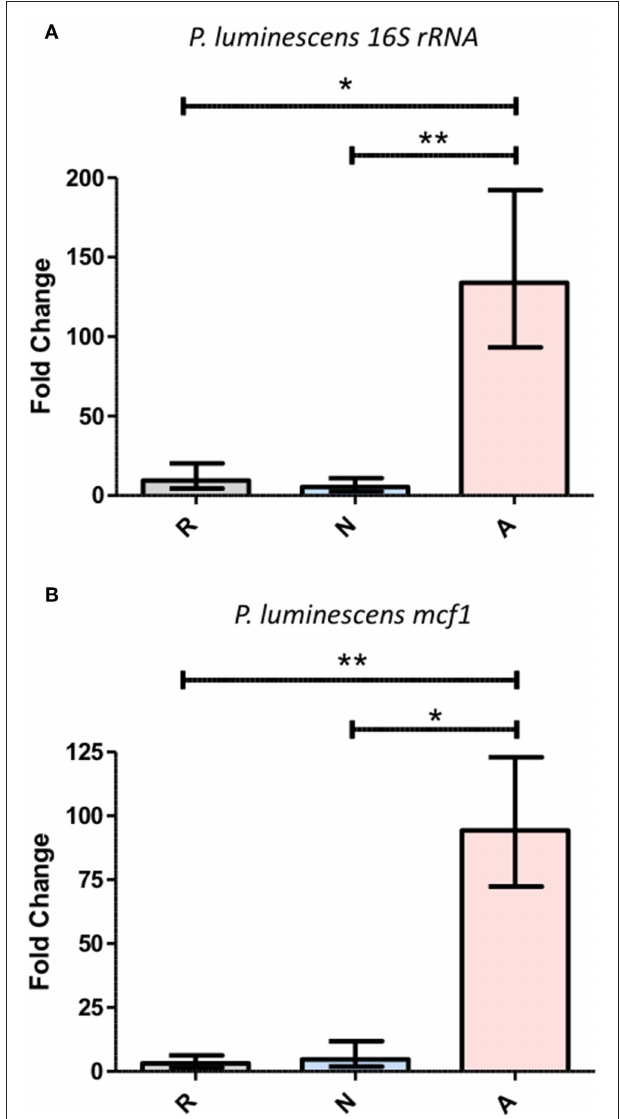
FIGURE 8 | Activated Heterorhabditis bacteriophora ES products enable the rapid proliferation of Photorhabdus luminescens during the early phase of an infection. A 1:4 mixture of OD 0.4 P. luminescens and Ringer’s buffer (R), non-activated ES products (N), or activated ES products (A) was injected into the thorax of adult Drosophila , which were then incubated for a period of 14h. Following RNA extraction, gene expression was measured by RT-qPCR for P. luminescens 16S rRNA (A) as well as mcf (B) , both of which were normalized to rp49 . Each graph shows fold change in expression between the 0 and 14h time points. Three trials of two replicates with five flies per replicate were performed (* p < 0.05, ** p <